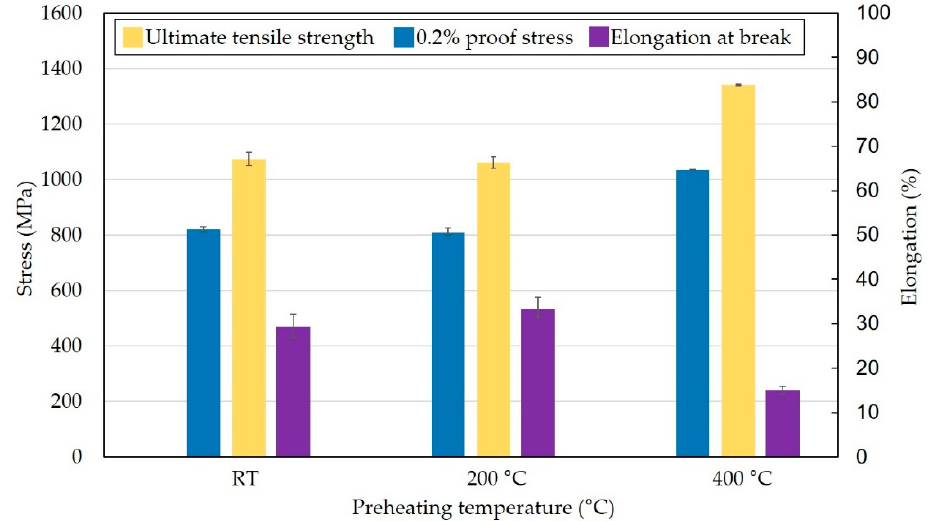
Figure 8. IN939 tensile properties of the specimens produced using RT and base plate preheating at 200 °C and 400 °C.